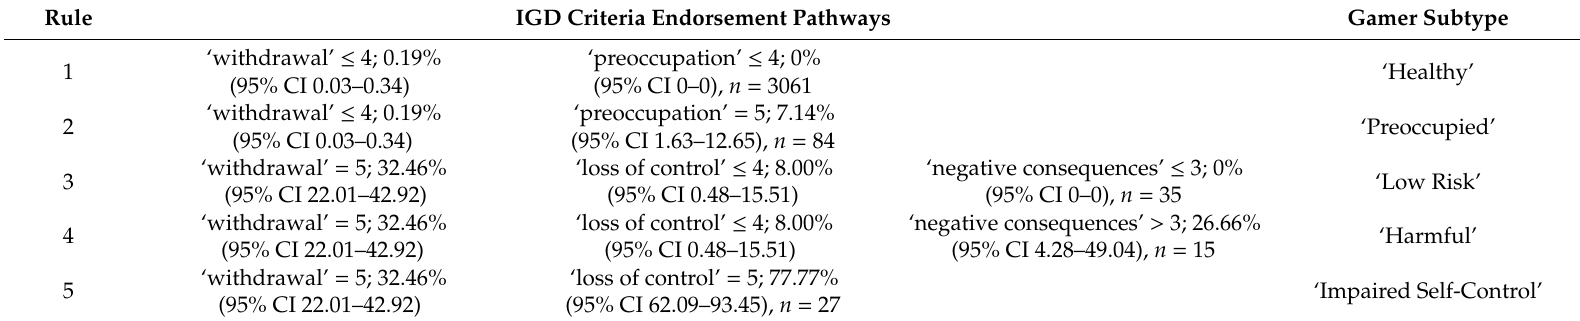
Table 2. Summary of the Conditional Inference Tree-derived rules alongside each Internet Gaming Disorder (IGD) criteria endorsement pathway according to each subtype of gamer within the sample ( N =